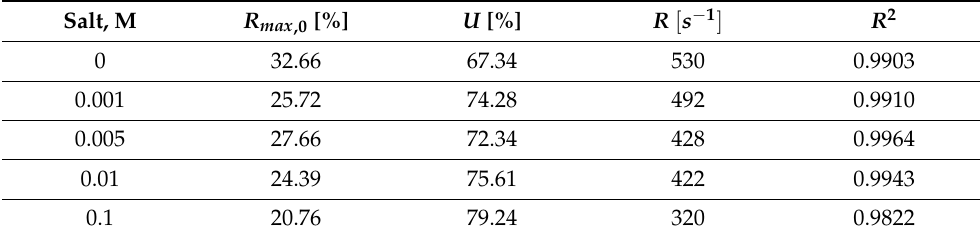
Table 4. Parameters of Equation (10) for the best representation of the data in Figure 10.